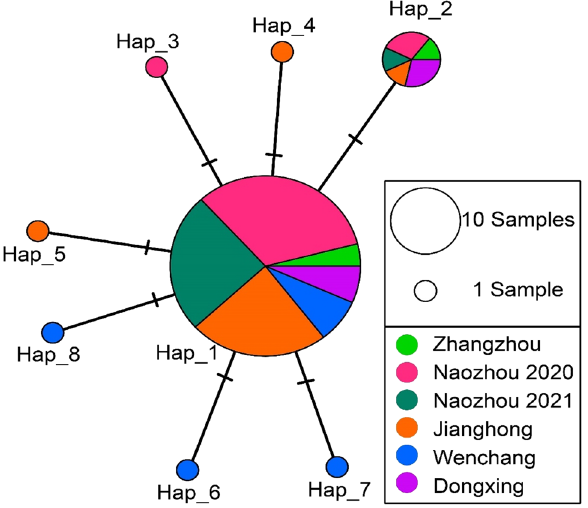
Figure 4. Median-joining network of haplotypes of the CO I gene sequences of E. tetradactylum . Each dash represents a single mutation step, haplotype frequency is related to the size of the circle. Different colors within the nodes refer to various sampling groups.